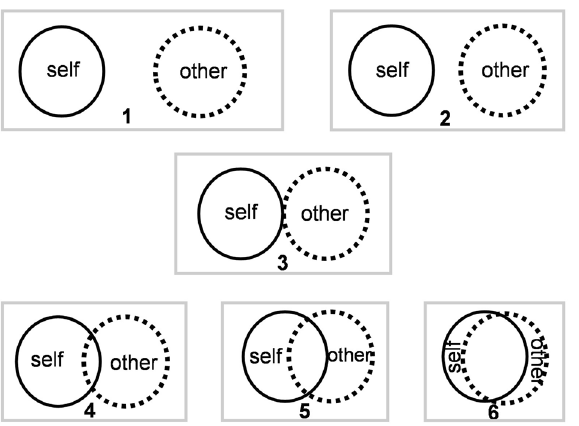
Figure 2. The modified version of the IOS scale used in the study. The solid circles represent the ‘self’ and the dotted circles represent the ‘other’. The cases with no overlap between circles represent negative closeness (i.e., distance or animosity). Closer circles indicate a closer relationship. Therefore, the pairs enclosed in boxes correspond to: 1-moderately distant, 2-slightly distant, 3-neutral, 4-slightly close, 5-moderately close and 6-extremely close perceived feelings toward the